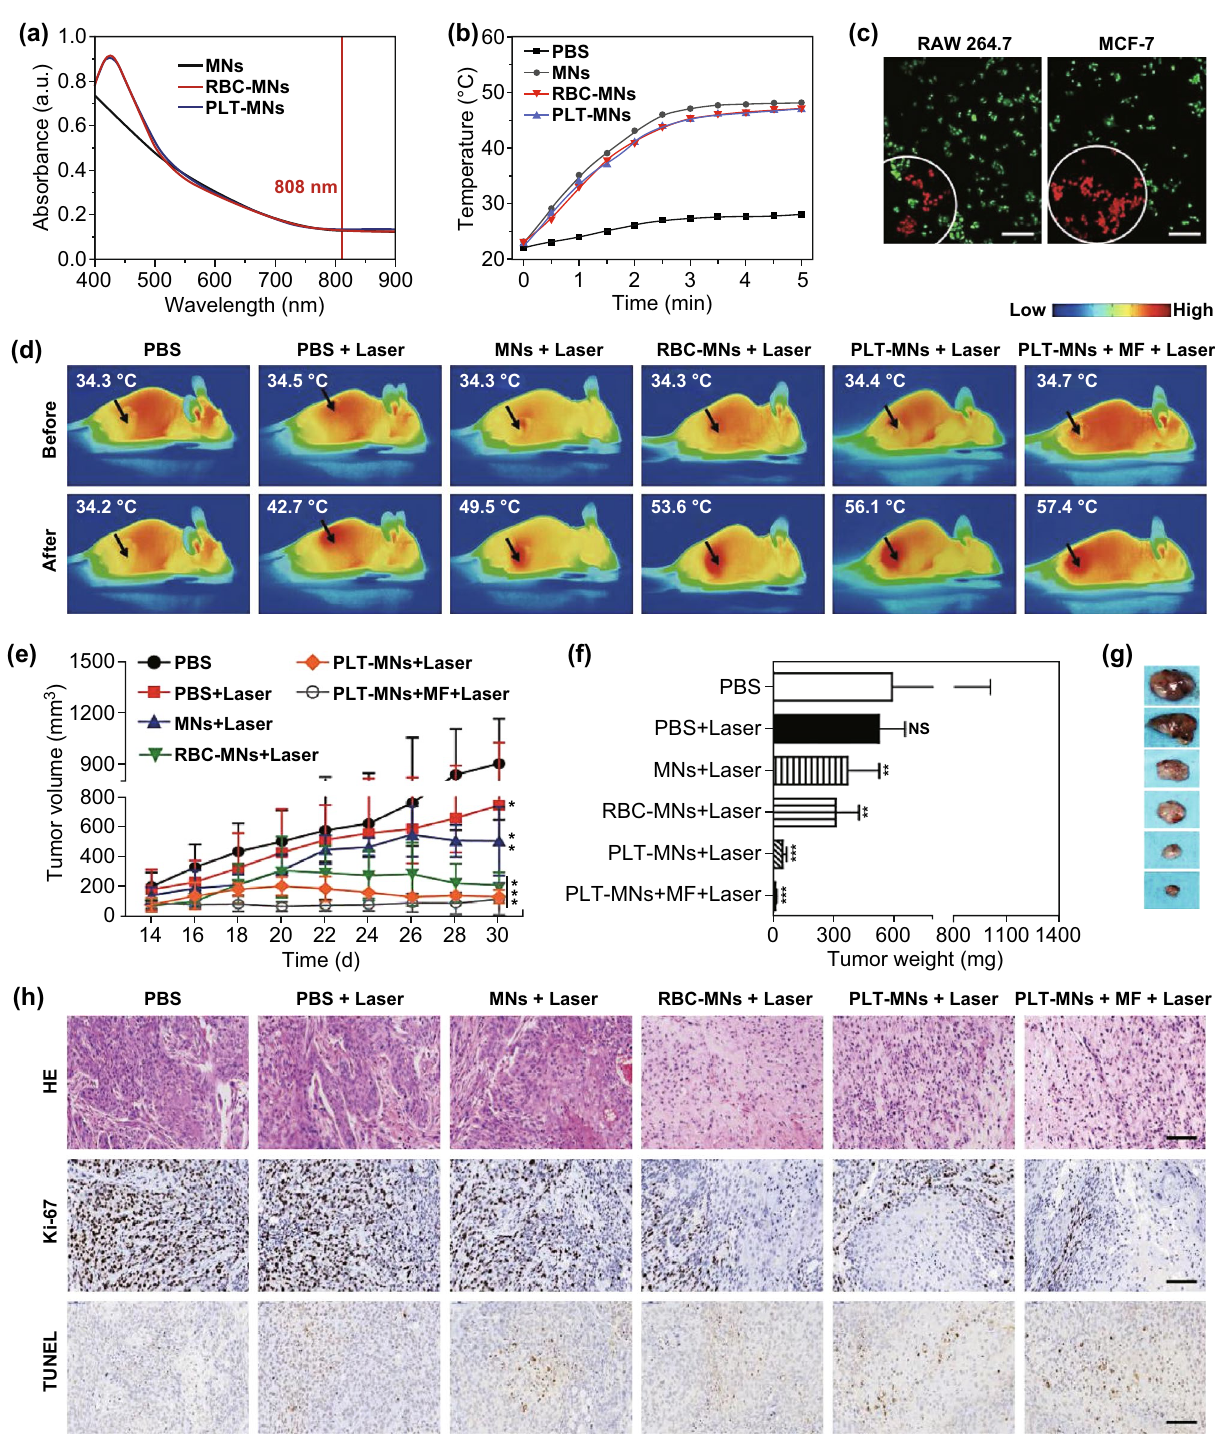
Fig. 8 a NP UV–Vis absorption spectra. b Temperature change for control or NP preparations following 808 nm laser irradiation. c CLSM results from RAW 264.7 and MCF‑7 cells following PLT‑MN treatment and laser irradiation. FDA (green) and PI (red) were used to detect live and dead cells, respectively. Scale bar = 100 µm. d Representative in vivo IR thermal images from mice implanted using MCF‑7 tumors follow‑ ing the indicated treatments. e Tumor volumes and f average weight following the indicated treatments. g Representative ex vivo tumor images and h HE‑, Ki‑67‑, and TUNEL‑staining of tumor tissue from differently treated animals. Scale bars = 200, 50, and 50 µm, respectively. Data are mean ± SEM ( n = 6). NS: no statistical difference, * p < 0.05, ** p < 0.01, *** p < 0.001, relative to PBS control. (Color figure online) Adapted from Ref. [115] with